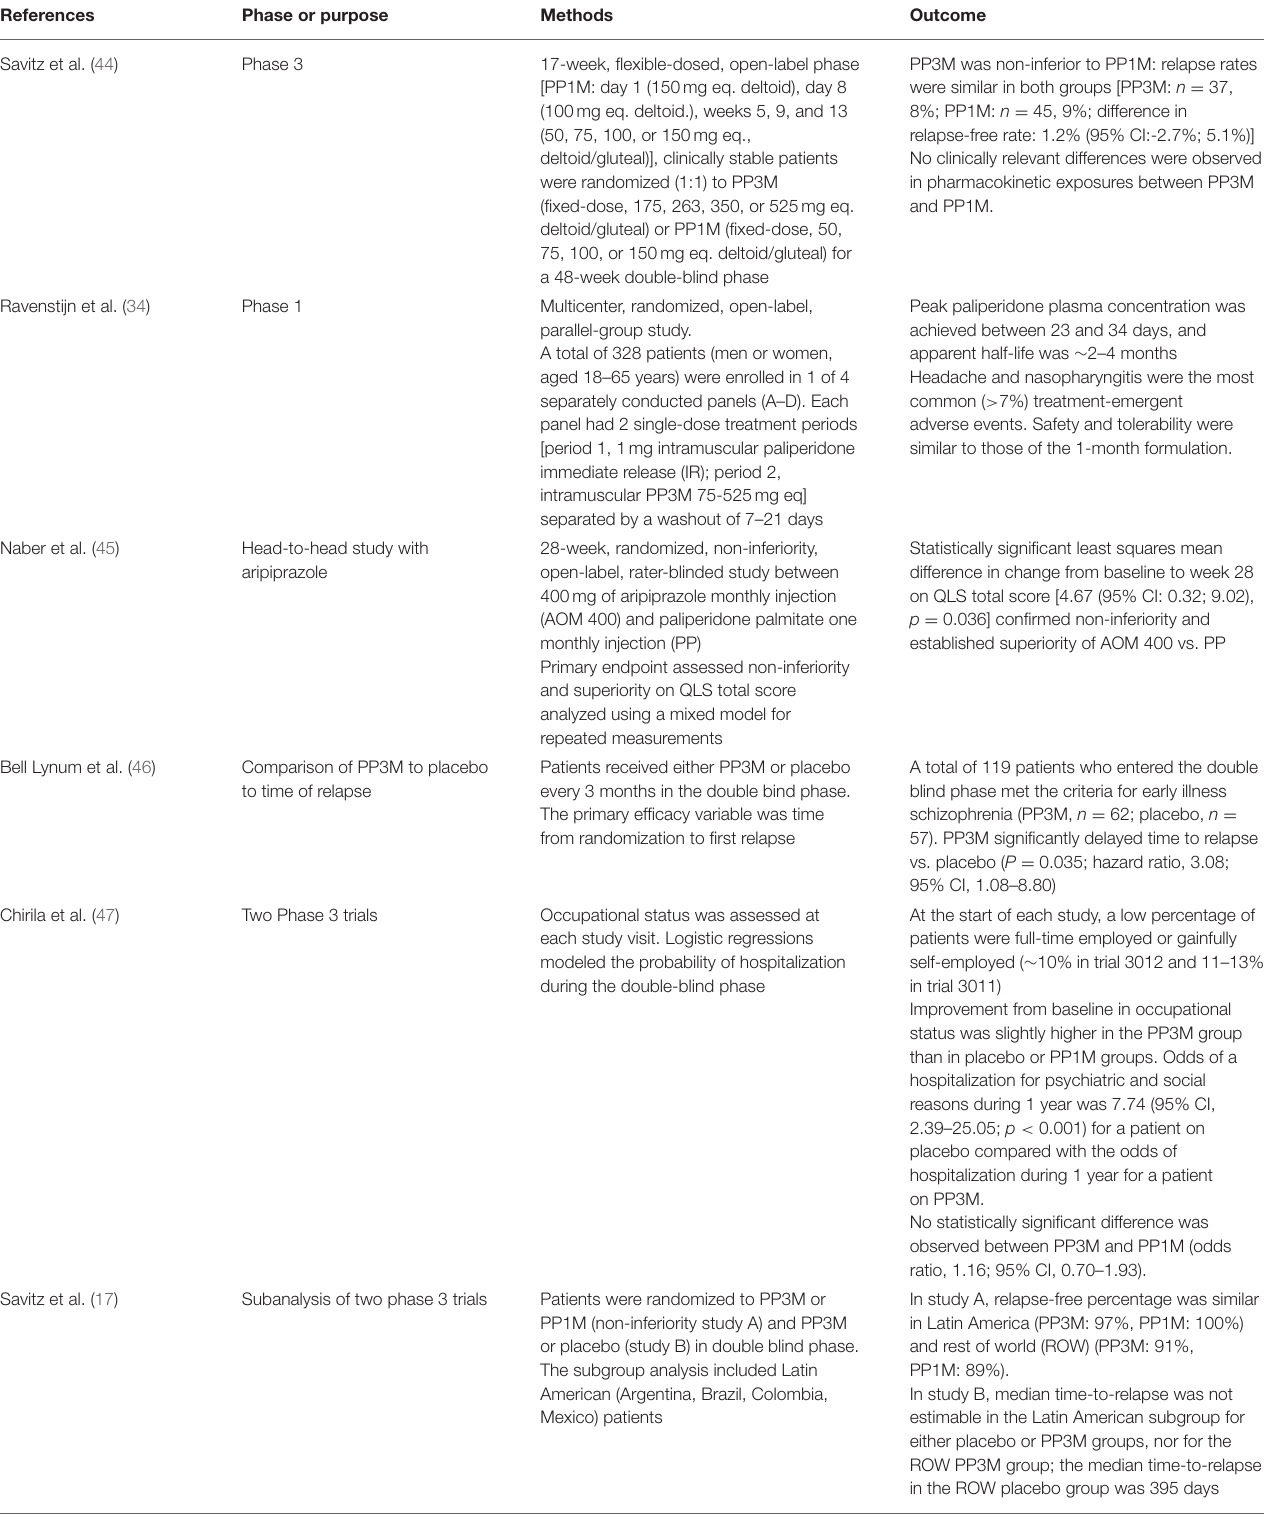
TABLE 2 | Summary of clinical